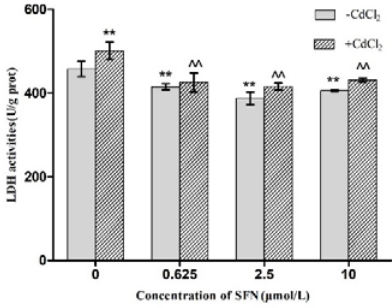
Figure 4. Effect of SFN on the LDH activity of Cd ‐ exposed TM4 cells * p < 0.05 as compared to the control group, ** p < 0.01 as compared to the control group, ^^ p < 0.01 as compared to the Cd group.